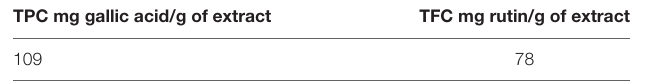
TABLE 1A | IC 50 of antioxidant tests DPPH, FRAP, and NO scavenging of O. limbata . Antioxidant test